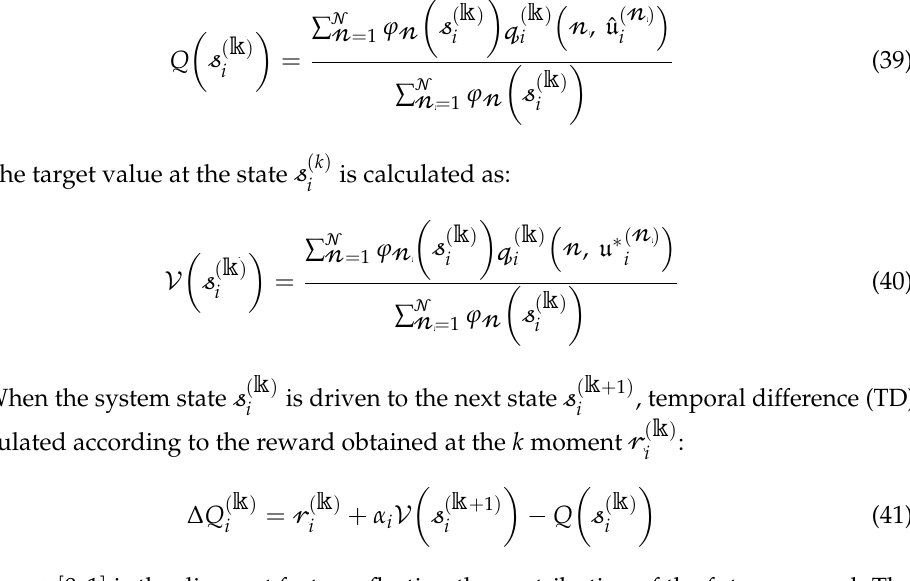
Figure 2. Membership function of fuzzy input of the 𝑖 (cid:3047)(cid:3035) subsystem.